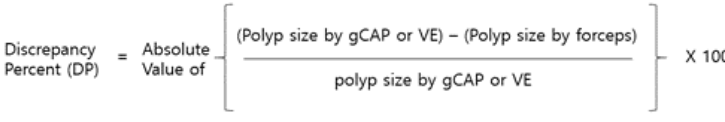
Figure 2. Formula for calculating discrepancy percent (DP).